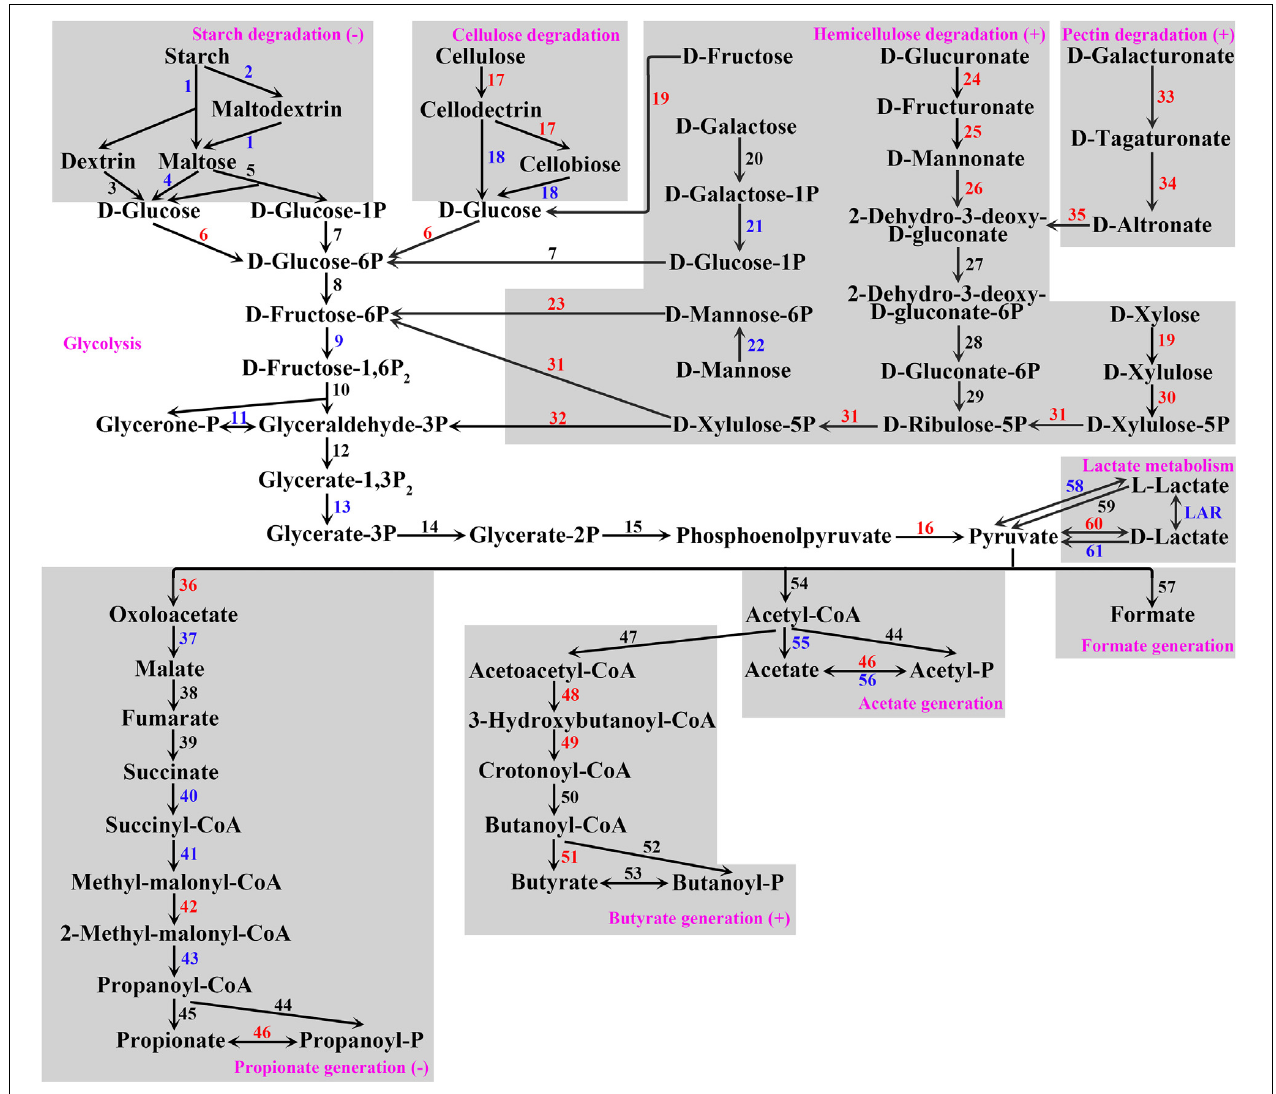
FIGURE 1 | SCFA generation pathway constructed for the ruminal microbiome in the present study. Gray boxes frame sub-pathways, with (–) indicating downregulation and (+) indicating upregulation of sub-pathways by urea supplementation. Pathway enzyme genes are coded by numbers (for code, see Supplementary Table 4 ) with red indicating increased (FDR < 0.05) and blue indicating decreased (FDR < 0.05) relative abundance of this enzyme gene by urea supplementation. Enzyme genes 27–32 are common enzyme genes of pectin and hemicellulose degradation. Enzyme genes 44 and 46 are common enzyme genes of acetate and propionate generation. For further details of pathway enzyme genes, see Supplementary Table 4